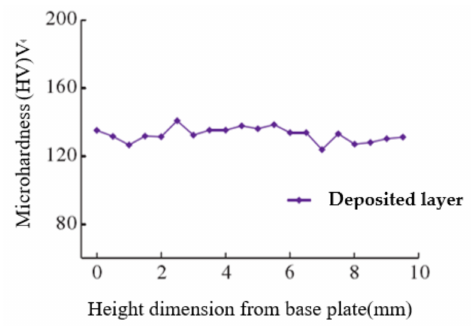
Figure 2. Microhardness distribution of deposited samples [16].